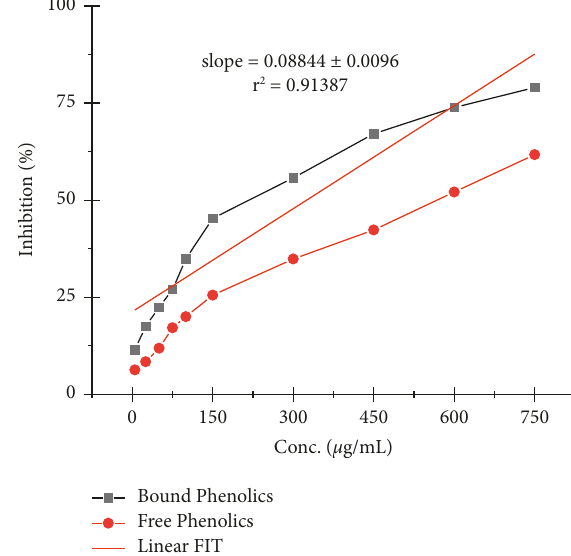
Figure 3: α -Amylase median inhibitory potential of Veronica biloba